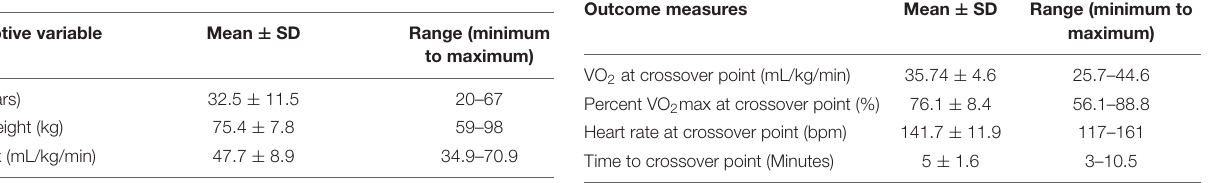
TABLE 1 | Descriptive characteristics of the study population of runners ( n = 18) and grapplers ( n = 8).